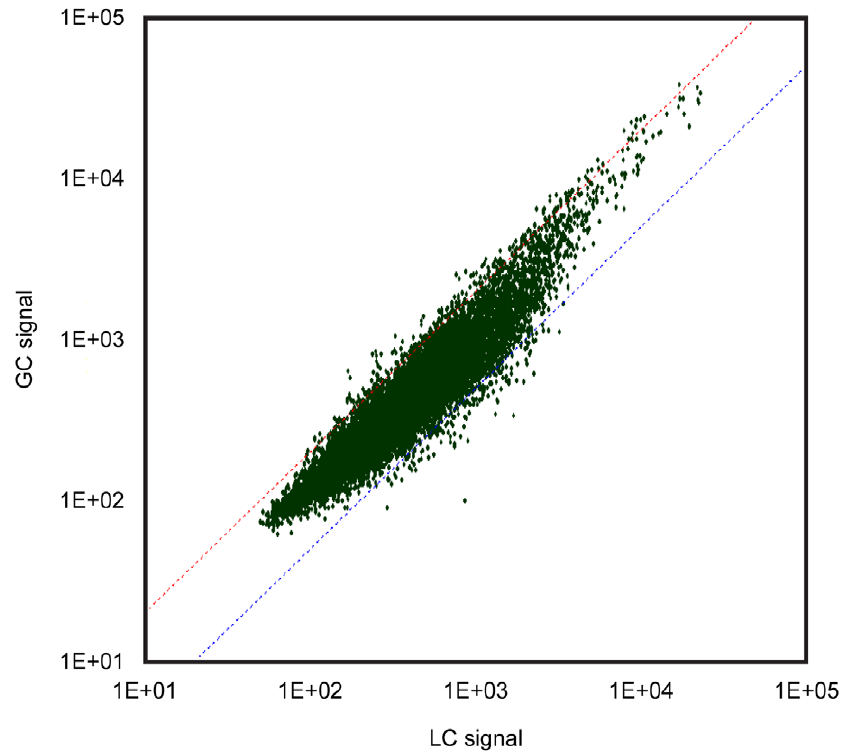
Figure 3. Scatter plots showing the relationship of gene expression between group LC and GC. The dots above and below the dotted slanted lines show the genes in group GC up- and down-regulated, more than 2 folds and/or less than half, vs. those in group LC, according to SAM analysis. See Figure 1 for the abbreviations.